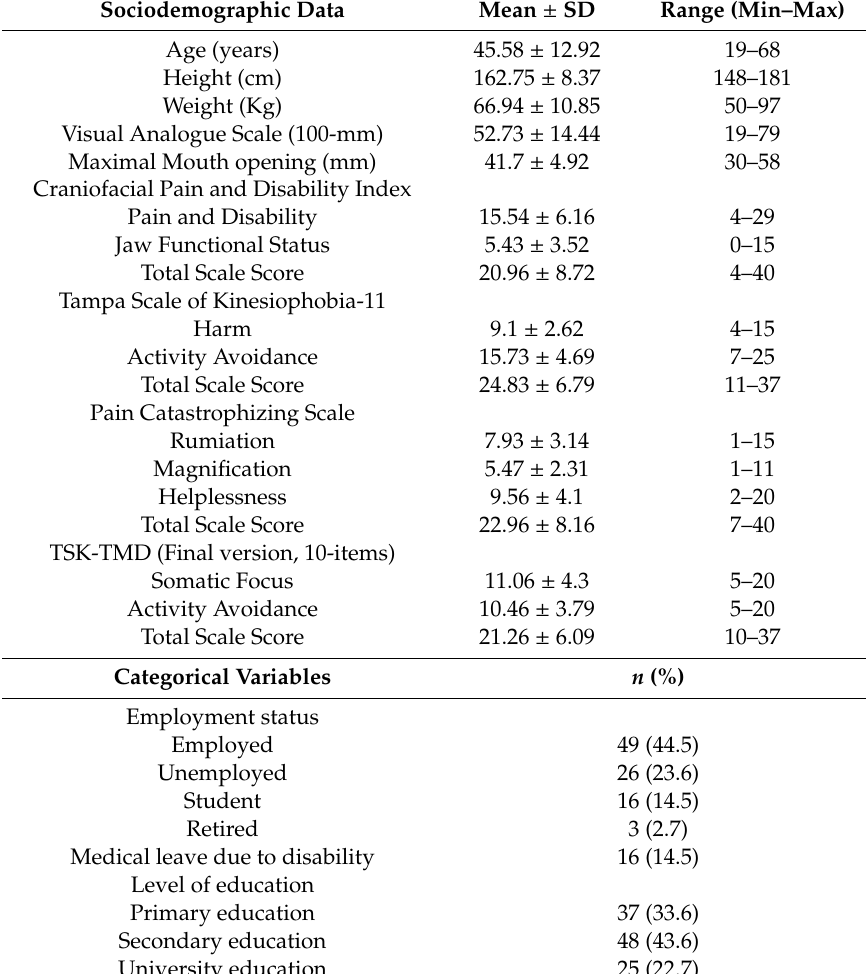
Table 1. Sociodemographic data and scores obtained on the self-reported